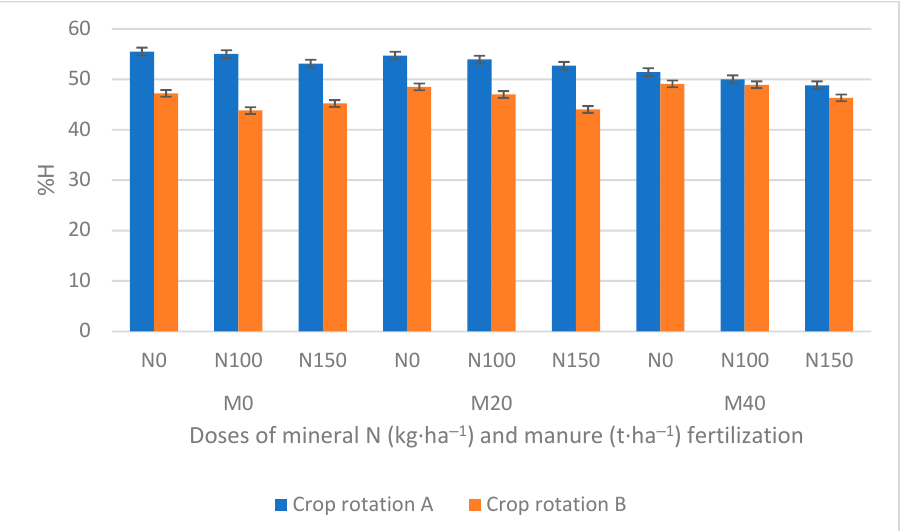
Figure 5. Humins (H) contents in in the topsoil layer (0–30 cm) as influenced by crop rotation (I), manure application (II) and inorganic N rate (III) in the long-term field experiment at Grabow, Poland. Error bars denote standard deviations ( n = 3). LSD ( p ≤ 0.05): for I = 3.261, II = 2.623, III = 1.017, II/I = 3.710, I/II = 4.361, III/I = n.s., I/III = n.s., III/II = n.s., II/III = n.s.